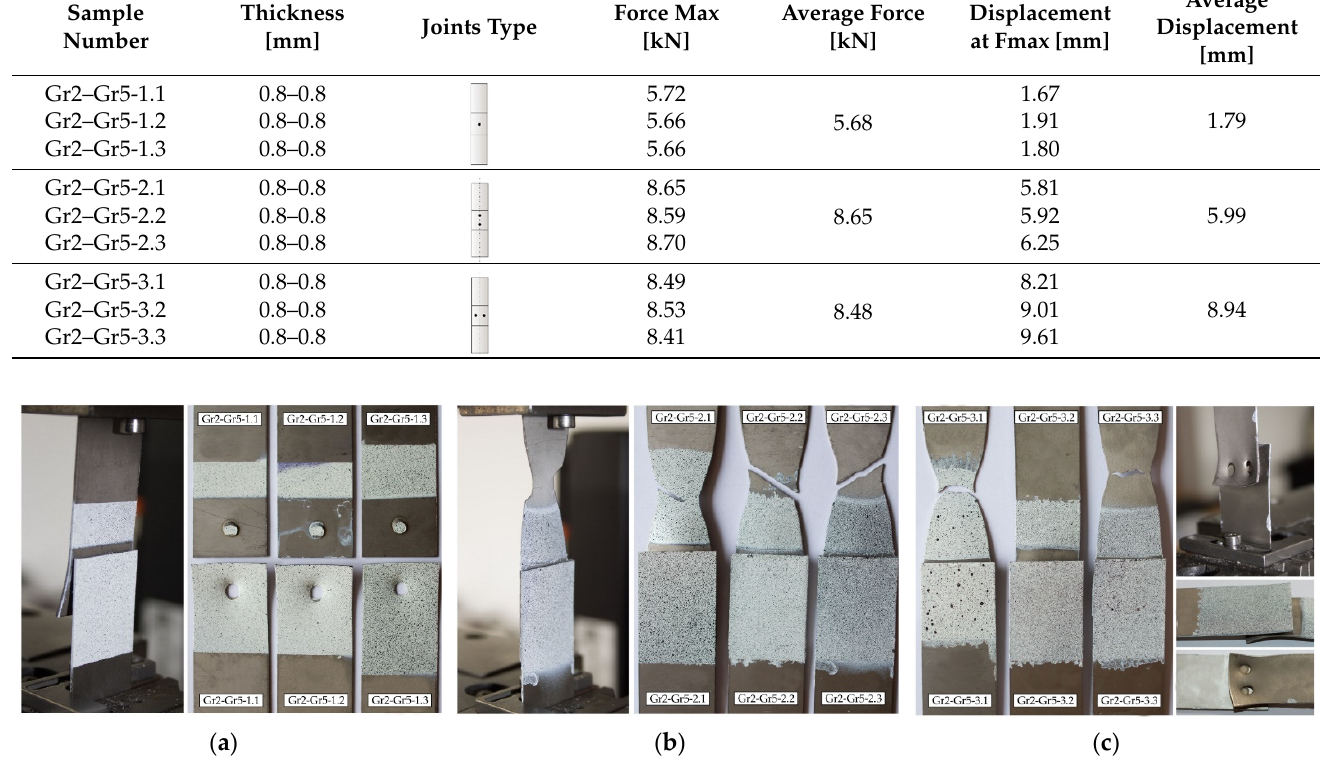
Figure 6. The method of failure of titanium samples in a tensile shear test: ( a ) with a single weld— Gr2–Gr5.1; ( b ) with two welds arranged parallel to the direction of tensile shear—Gr2–Gr5.2 and ( c ) with two welds arranged perpendicular to the direction of tensile shear—Gr2–Gr5.3. A summary of the results from the tensile shear test of the Gr5–Gr5 titanium joints is presented in Table 7.